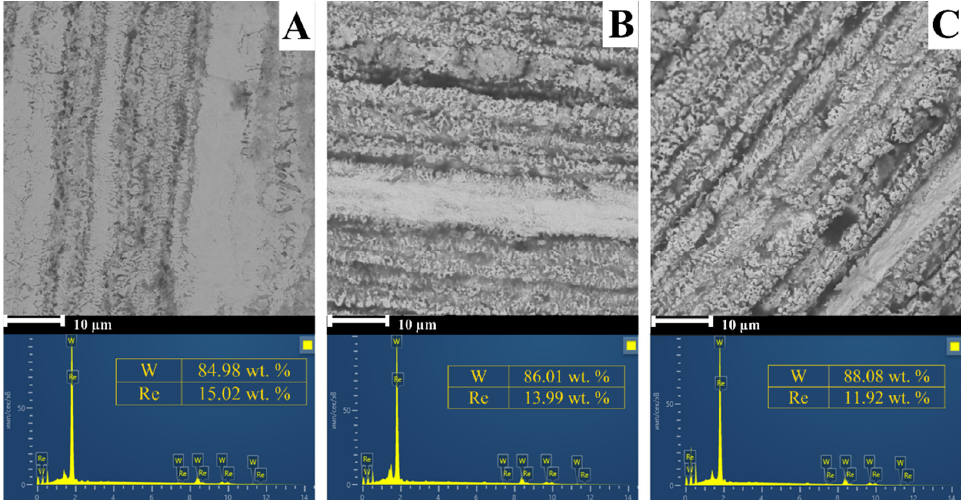
Figure 4. Microstructure of initial alloy ( A ), alloy after 3000 s exposure in solution ( B ), and alloy after 6000 s exposure in the solution ( C ).